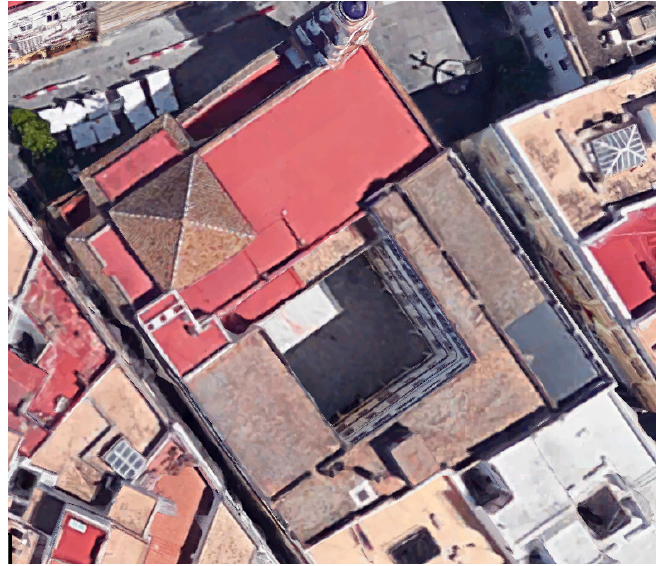
Figure 2. Aerial view of the building in the case study.